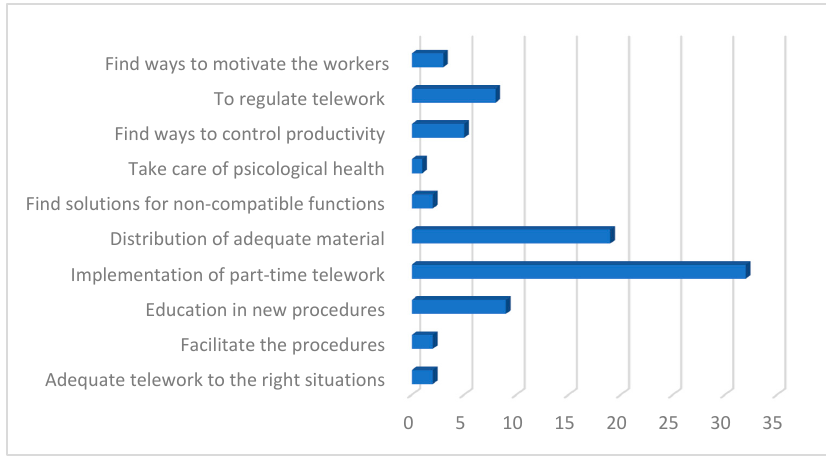
Figure 10. Solutions to minimize the negative impacts of telework. Table 1. Results of the chi-square test of productivity*education.